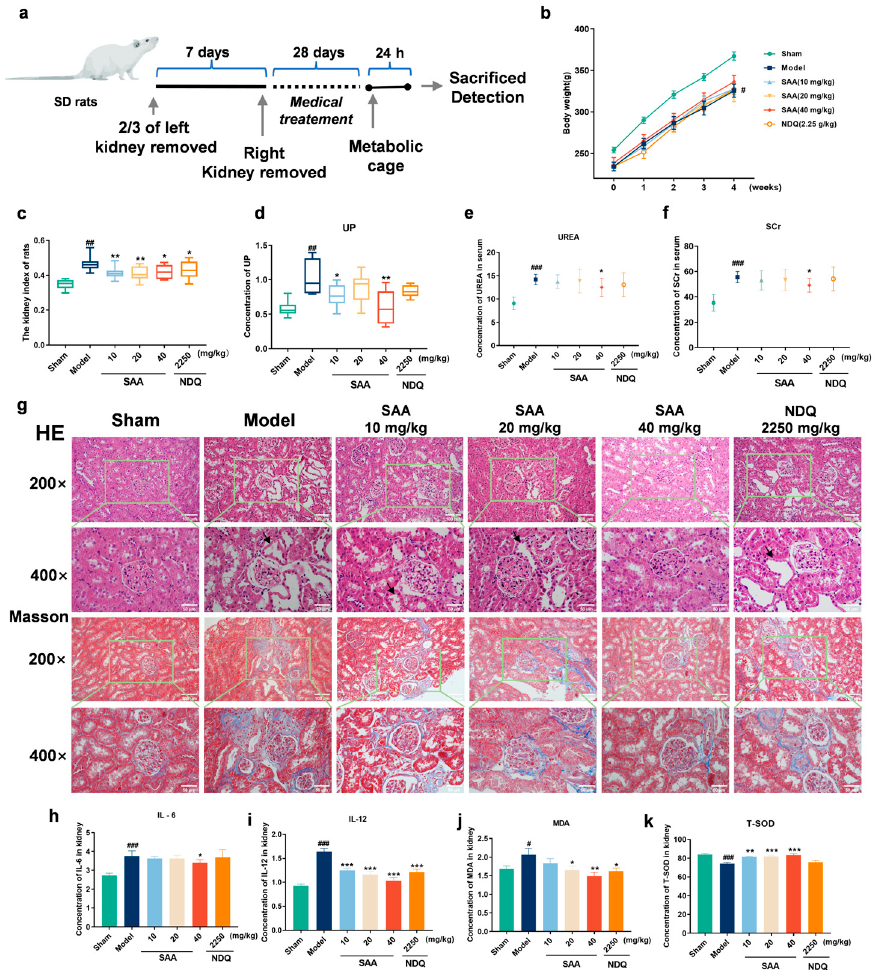
Figure 2. The effects of SAA on CKD rats. ( a ) SAA suppressed kidney injury in CKD rats. ( b – d ) The effects of SAA on ( b ) the body weight, ( c ) the kidney index ( n = 10–12, # p < 0.05, ## p < 0.01 compared with Sham group. * p < 0.05, ** p < 0.01 compared with Model group), and ( d ) the content of UP. n = 8–14. ( e , f ) Effect of SAA on serum ( e ) UREA and ( f ) SCr in rats with CKD ( n = 4–6, ## p < 0.01, ### p < 0.001 compared with Sham group. * p < 0.05, ** p < 0.01 compared with Model group). ( g ) Kidney histopathological changes and tubulointerstitial fibrosis were examined by H&E staining and Masson staining in kidney sections of CKD rats ( n = 3, magnification: 200×, 400×, scale bar = 50 μ m), black arrow indicates kidney tubular dilatations. All data are shown as mean ± SEM, n = 8–14. # p < 0.05, ## p < 0.01, ### p < 0.001 compared with Sham group. * p < 0.05, ** p < 0.01 compared with Model group. ( h – k ) Effect of SAA on the content of ( h ) IL-6, ( i ) IL-12, ( j ) MDA and ( k ) T-SOD in the kidneys of CKD rats. All data are shown as mean ± SEM, n = 4–6. # p < 0.05, ### p < 0.001 compared with